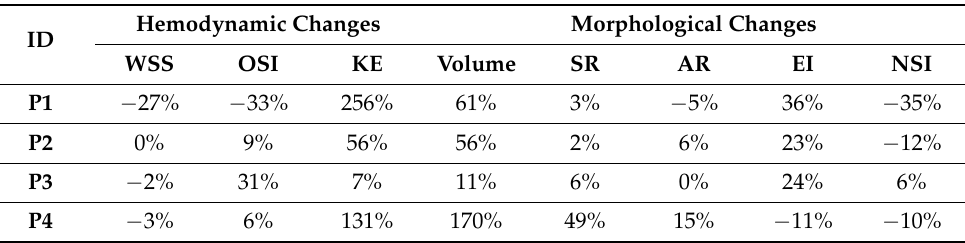
Table 2. Summary of changes in hemodynamic and morphological parameters in each aneurysm. Changes listed are average values per year of aneurysm growth (see Table 1).